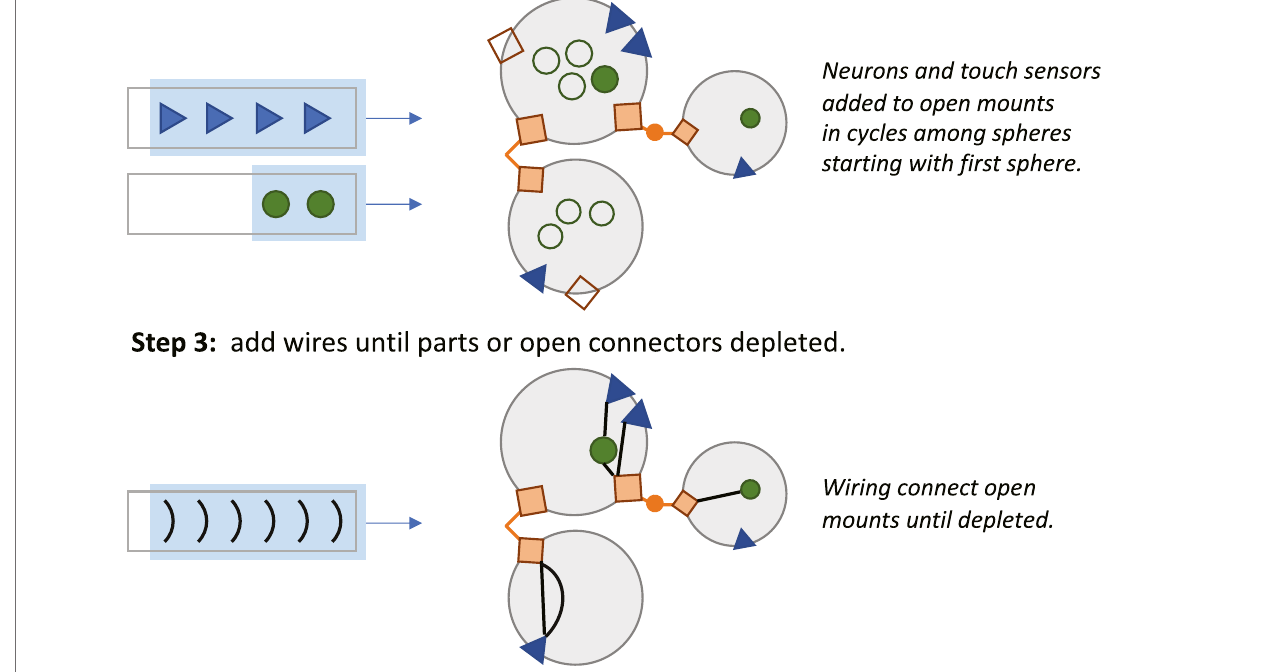
FIGURE 3 | Robot assembly during late development. Step 1: Drawing from the part pools (rectangular boxes), development assembles the robot ’ s body by fi rst connecting a pair of spheres with a joint. This process is repeated until unused spheres, joints, or open joint mounts (empty orange squares) are depleted. Step 2: Developmentaddsneurons( fi lledgreencircles)andsensors( fi lledbluetriangles)tothemountsonthespheres(emptycirclesandtriangles)untiltheunusedpartsoropen mounts are depleted. Step 3: Unless depleted or without open connections, wires placed to link sensors to neurons, sensors to motors, and sensors to motors.